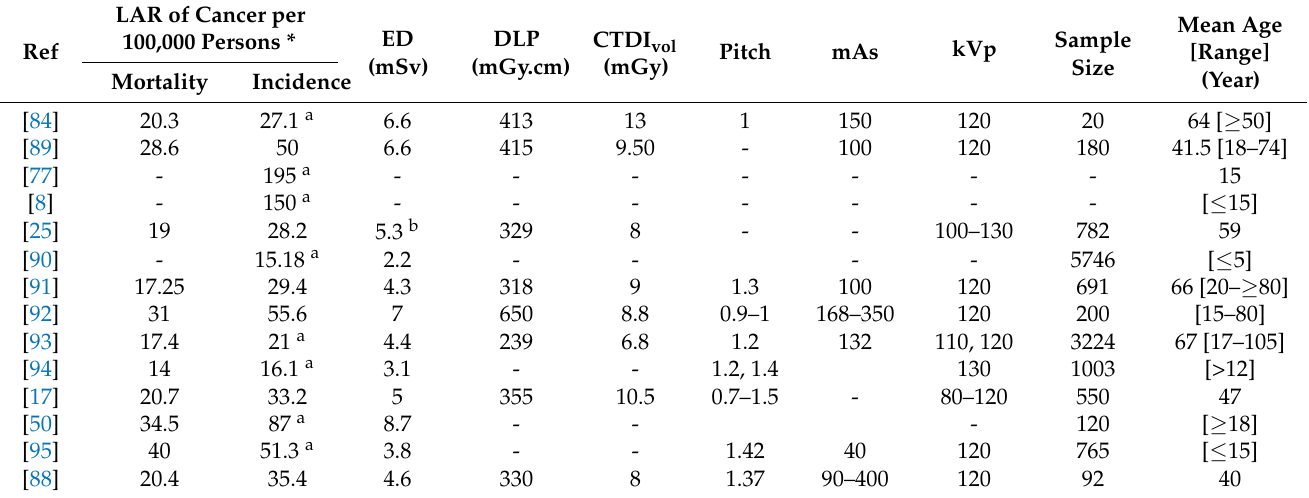
Table 5. The main scan settings, radiation doses and sex-averaged lifetime attributable risk of cancer incidence and mortality from standard-dose chest CT in the